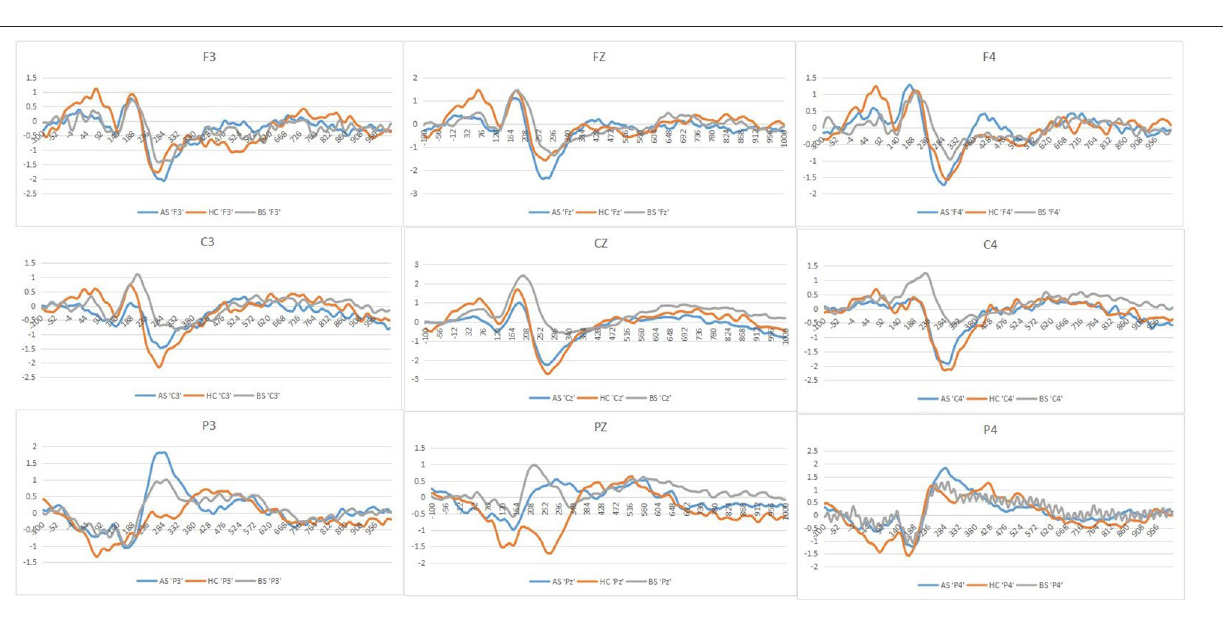
Stimulus type ∗ Group [ F (4, 148) = 3.14, p = 0.01, η 2 no interaction effect of the Hemisphere ∗ Group [ F (4, 148) = 1.68, = 0.04]. Post-hoc results showed that the effect of p = 0.17, η 2 p